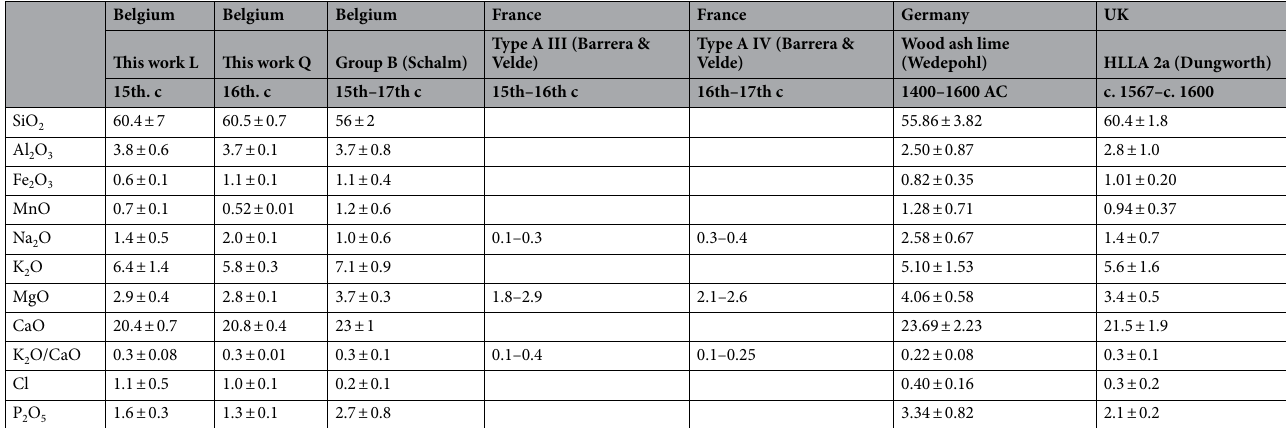
Table 1. Comparison between glass identified in this work and fifteenth to seventeenth c. material from Belgium 3 , fifteenth to seventeenth c. French material 15 , fifteenth to seventeenth c. wood ash lime glass from Germany 14 , and British sixteenth to seventeenth c. material 16